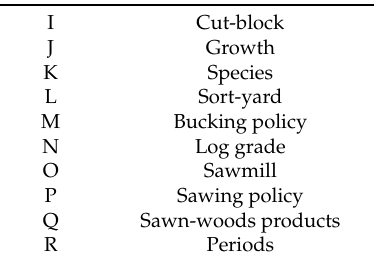
Table A1. Model’s